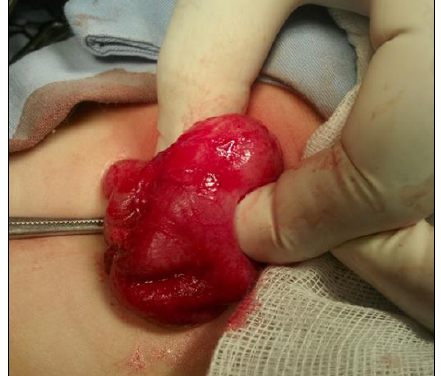
Figure 1: Operative view (in the second pyloromyotomy) showing a regular scar along the complete length of the pyloric muscle on the anterior